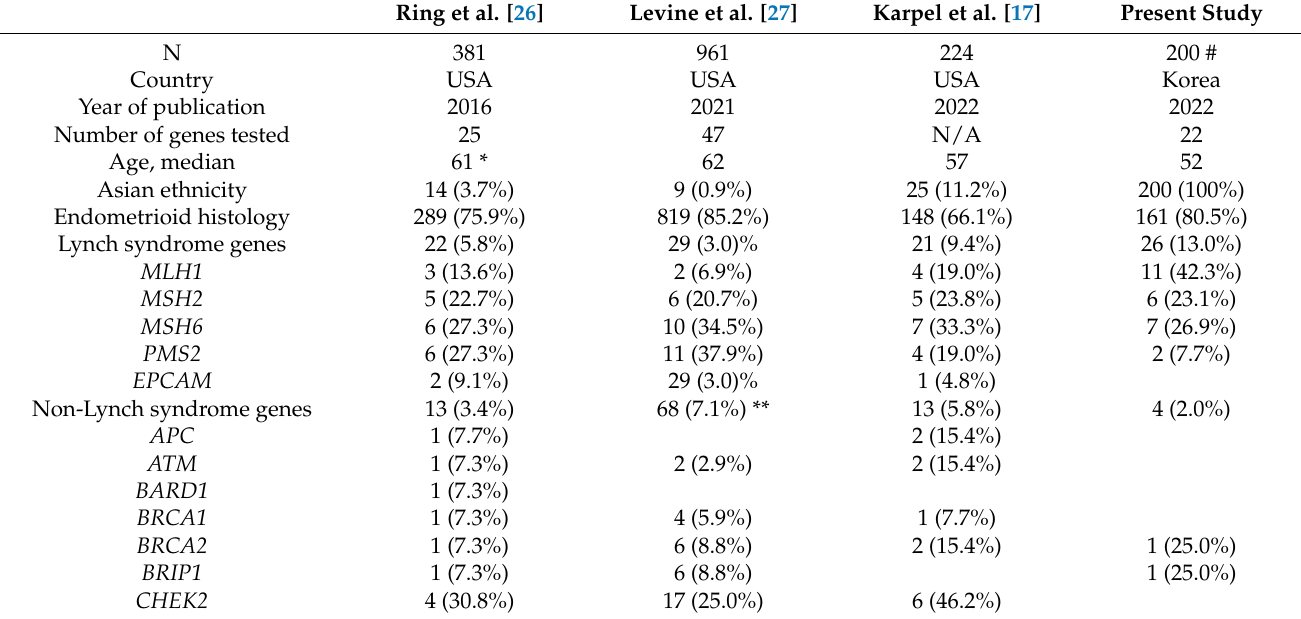
Table 5. Literature review of multigene panel testing in patients with endometrial